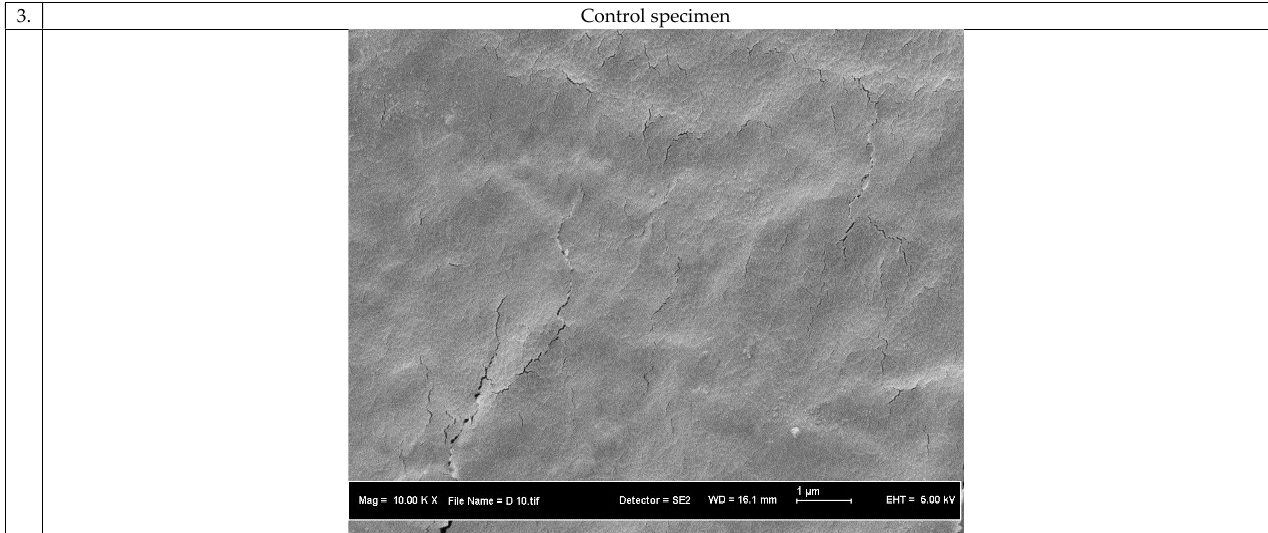
Figure 10. Cell morphology on the cross section of the 3D scaffolds after 5 days’ cell seeding.